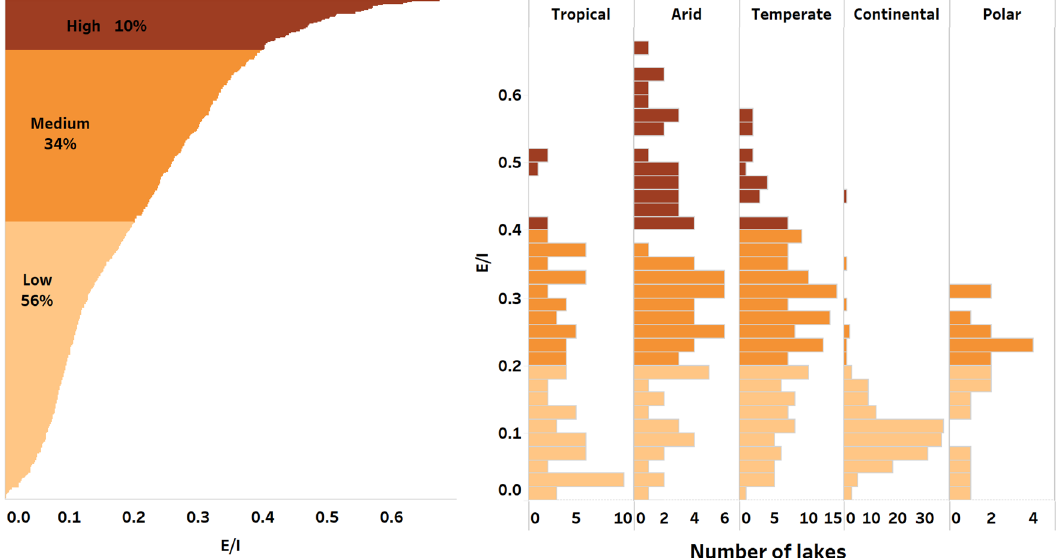
Fig. 3 Isotope-based evaporation losses from global lakes. Relative proportion of Earth ’ s lakes evaporation losses (E/I) and by climatic